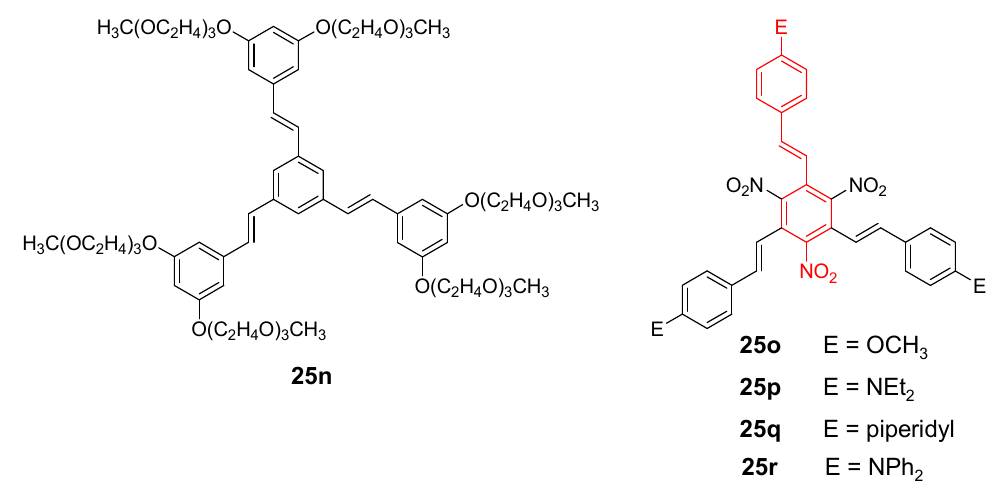
Figure 13. Compounds 25n and 25o - r . The structure of the linear counterpart, whose properties are investigated for comparison, is highlighted as red substructure in the star